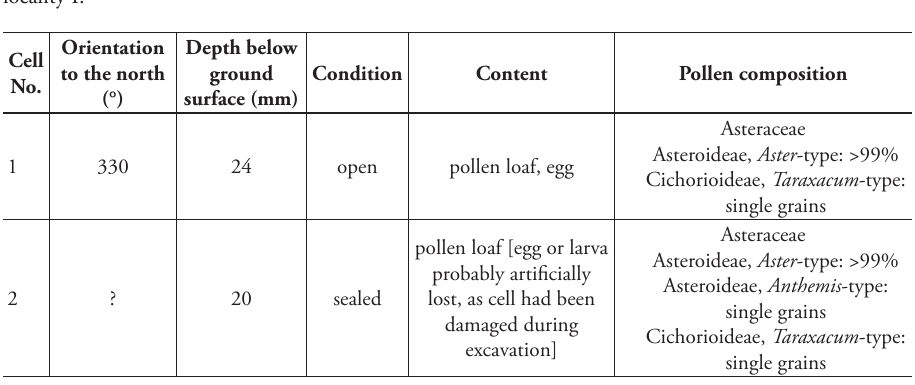
Figure 15. Schematic vertical cross sections of the nest architecture and brood cell arrangement of nest CH and nest GB of Quartinia major investigated on 15 April, 2017 at locality I (c = brood cell with cell number, ls = little stone, s = main shaft, t = turret). Table 2. Details of the brood cells of nest CH of Quartinia major investigated on 15 April, 2017 at locality